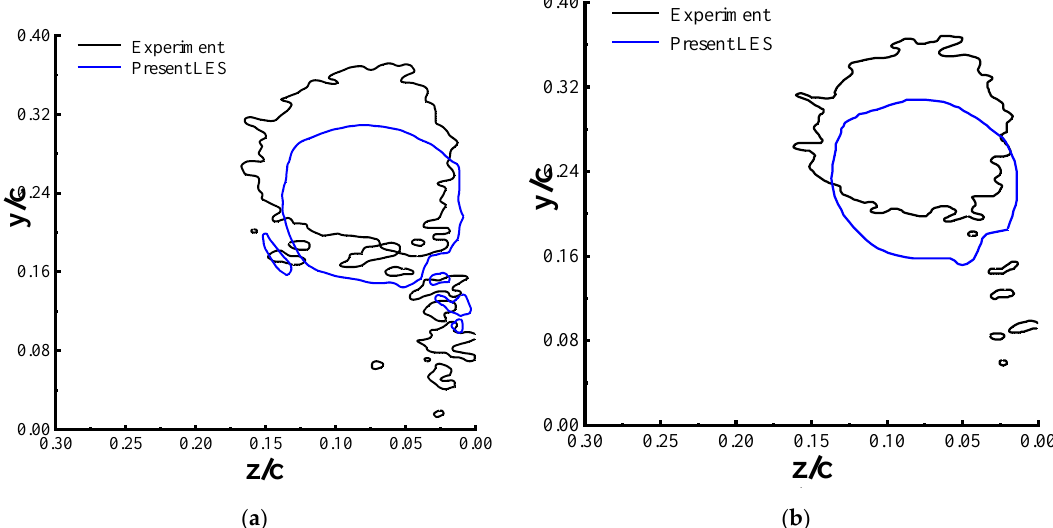
Figure 7. Comparison of iso-lines of the non-dimensional streamwise vorticity: ( a ) 𝜔 𝑧∗ = −2 , and ( b ) 𝜔 𝑧∗ = −3 .